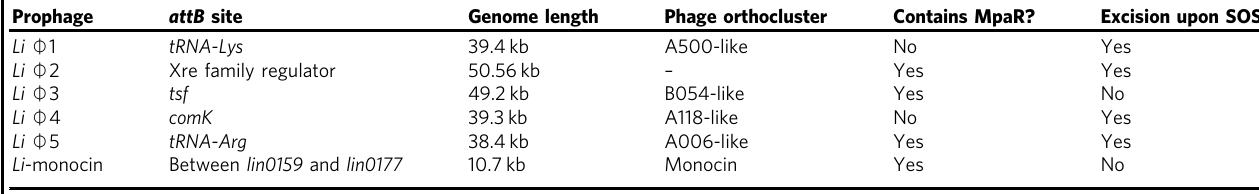
Table 1 Phage elements in L. innocua CLIP 11262.